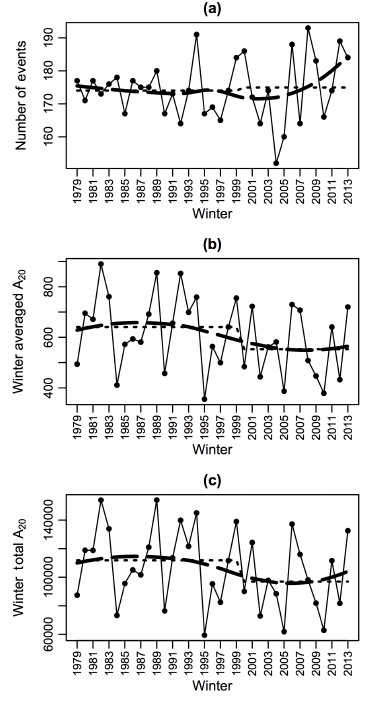
Figure 3. Winter (October–March) variability in (a) the number of windstorm events, (b) average A 20 and (c) total A 20 . Trends are de- picted by locally weighted scatter plot smoothing curves (dashed curves). Dotted lines show means in each variable in the 20th century (1979/1980–1999/2000) and the 21st century (2000/2001–